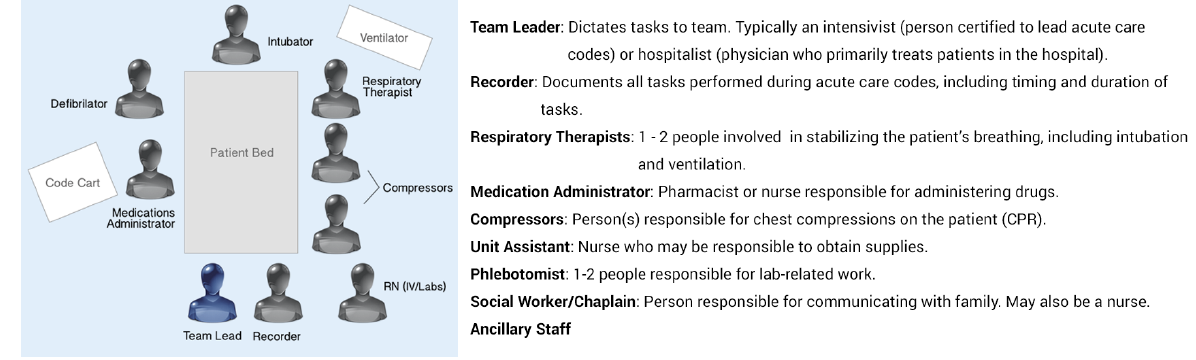
Fig. 2. The general positions of each clinician during an ACLS and PALS code, along with a description of each person’s role informed by our interviews.